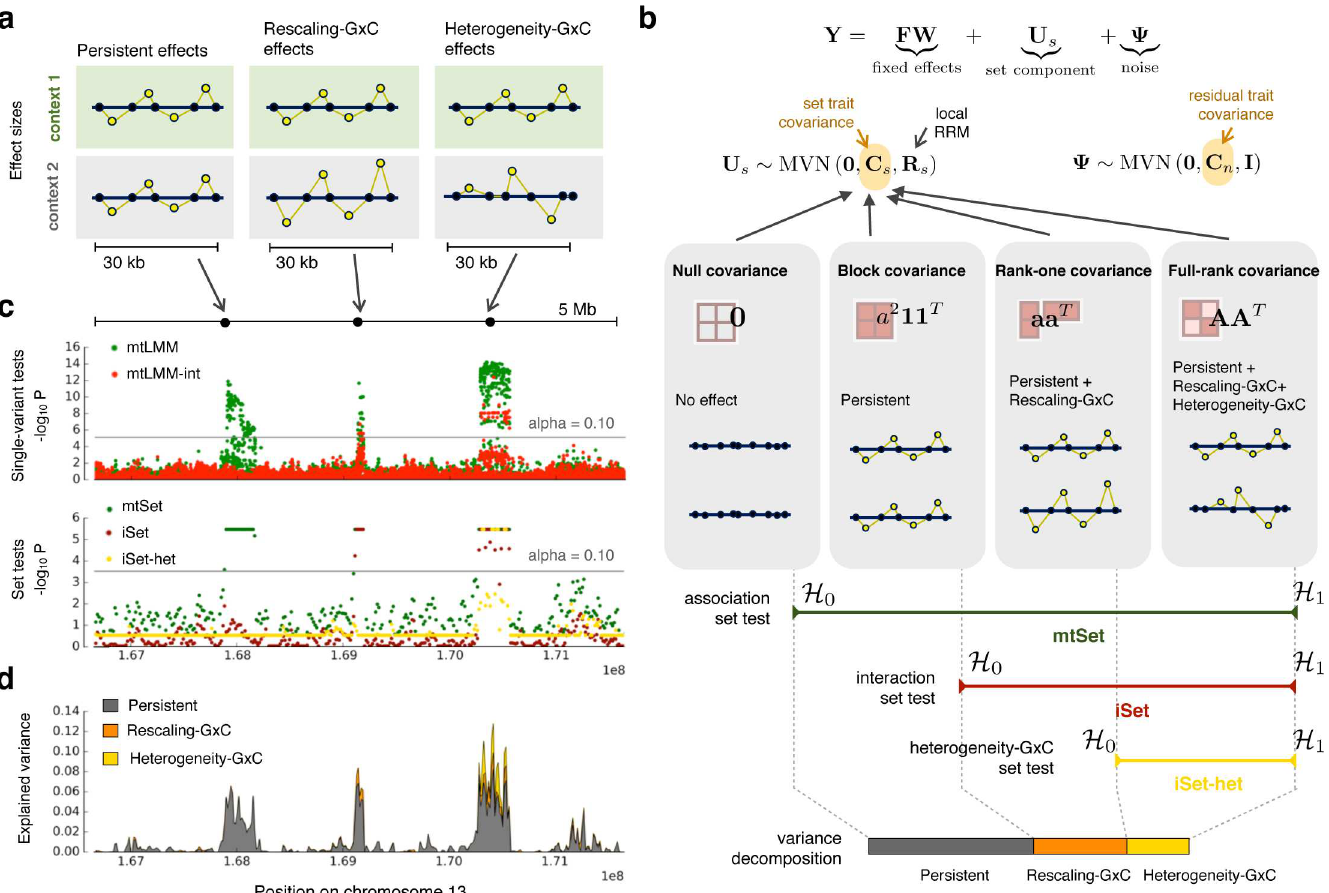
Fig 1. Illustration of the iSet model and different architectures of genotype-context interactions. (a) Alternative genetic architectures that are explicitlymodeledin iSet: persistent effects , where causal variants have identicaleffects across contexts (left panel), rescaling-GxC effects , where the effects of causal variants in one context are proportional to those in a second contexts (middle), and heterogeneity-GxC effects , with changesof causal variants or their relative effect sizes betweencontexts (right). (b) Illustration of the multivariate linear mixed model (LMM) that underliesiSet. Model comparisons of LMMs with different trait-context covarianceof the set component C s are used to define tests for generalassociations ( mtSet ), interactions ( iSet ) and heterogeneity-GxC effects ( iSet-het ). Additionally, the model can be used to estimate the proportionof variancethat can be attributed to the corresponding genetic architectures ( Methods ). (c,d) Applications of iSet to a small simulatedregion. The total genetic effect was simulatedas the sum of contributions from three loci with a persistent (left), rescaling-GxC (middle)and heterogeneity-GxC effects (right). (c) Manhattanplots of P values from a single-variant LMM [10] to test for associations(mtLMM) or interactions(mtLMM-int). Lower panel: Corresponding Manhattanplots for P values from set tests, considering a test for associations(mtSet), interactions(iSet) or heterogeneity-GxC (iSet-het), using consecutiveregions(30 kb regions; step size 15 kb). Horizontal lines correspondto the α = 0.10 significancethreshold (Bonferroniadjusted). P values of set tests are bounded( > 10 − 6 ) by the number null model simulations to estimate significance levels ( Methods ). (d) Proportionof varianceattributableto persistent effects, rescaling-GxC and heterogeneity- GxC, considering the same regions as in c